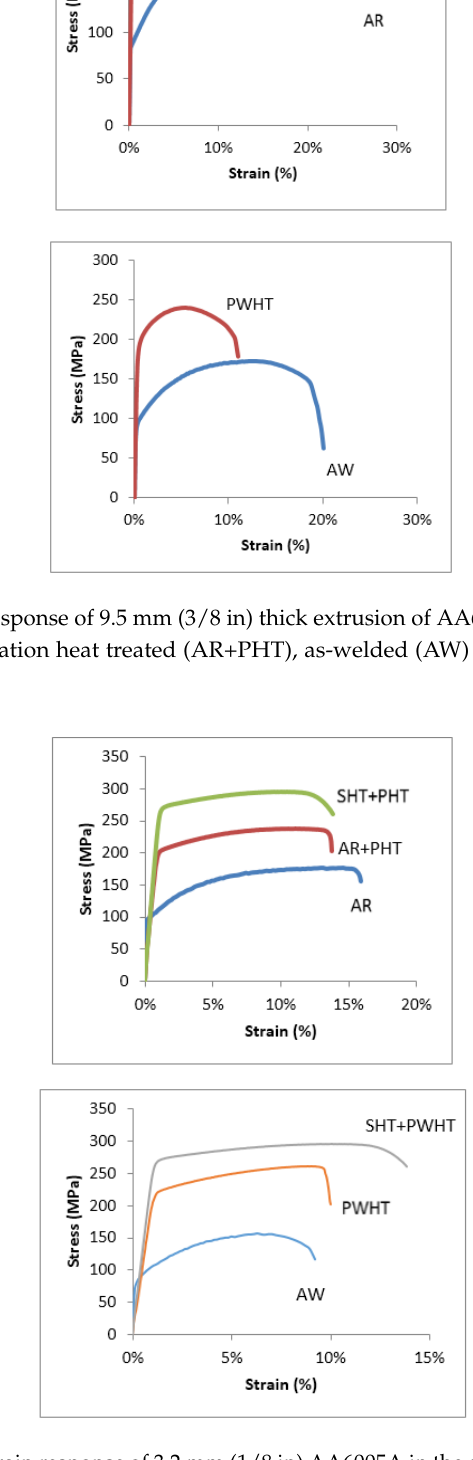
Figure 11. Stress versus strain response of 3.2 mm (1/8 in) AA6005A in the as ‐ received (AR), as ‐ received plus precipitation heat treated (AR+PHT), solution heat trearted plus precipitation heat treated (SHT+PHT), as ‐ welded (AW), post weld heat treared (PWHT) and solution heat treated plus post weld heat treated (SHT+PWHT) conditions.